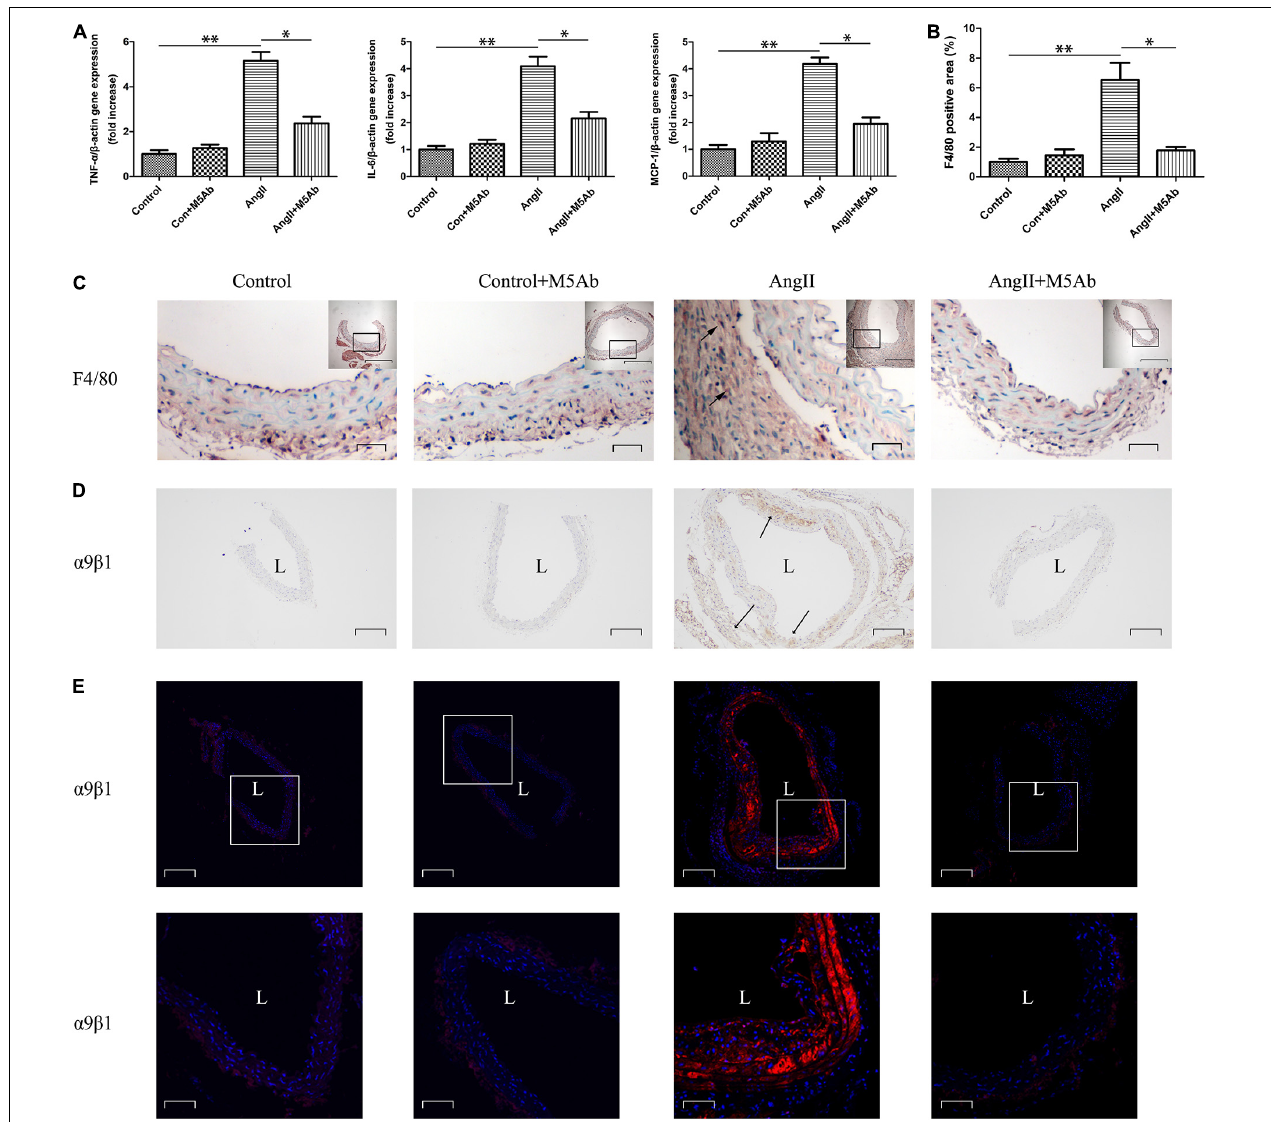
FIGURE 5 | M5Ab attenuates proinflammatory cytokine gene expression and inflammatory cell infiltration by blocking the expression of OPN-N. (A) qPCR analyses of the mRNA expression levels of TNF- α , IL-6, and MCP-1 in mice under different treatments. (B,C) Immunohistochemistry staining of F4/80 macrophages in mice under different treatments, quantification of these F4/80 area. Scar bars: 200 µ m (boxed areas), 25 µ m (main images). (D) Immunohistochemistry staining and (E) Immunofluorescence staining of α 9 β 1 in mice under different treatments. Scar bars: 200 µ m (above), 50 µ m (below). DAPI staining of nuclei:blue; α 9 β 1 staining:red. Data are expressed as means ± SEM; n = 3 per group. ∗ P < 0.05 vs the Ang II + M5Ab group; ∗∗ P < 0.05 vs the control and control + M5Ab groups. Abbreviations: Ang II, angiotensin II; IL, interleukin; MCP, monocyte chemoattractant protein; TNF, tumor necrosis factor; L,